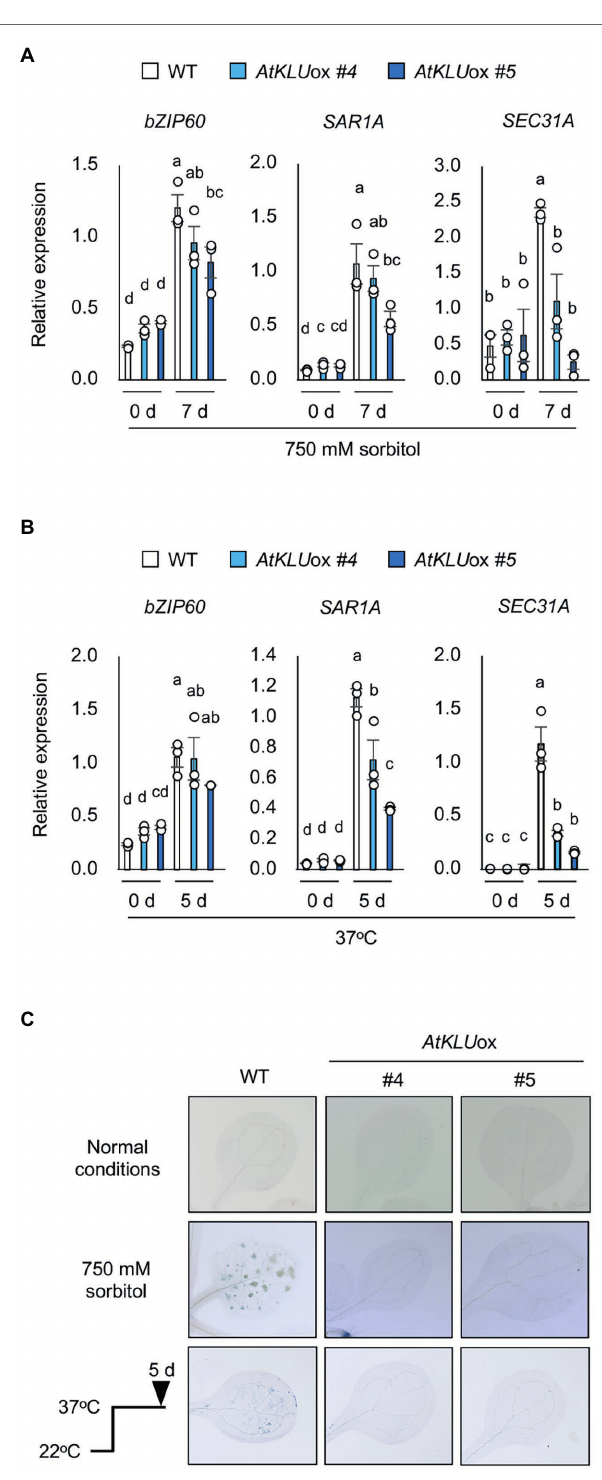
FIGURE 7 | those of Actin2 . Bars labeled with different letters differ significantly ( P < 0.05, one-way ANOVA with post hoc Tukey HSD test, mean ± SE, n = 3). (C) Trypan blue staining of leaves of WT or AtKLU ox plants under normal, osmotic stress (750 mM sorbitol for 7 days), and heat stress (37 ° C for 5 days) conditions.